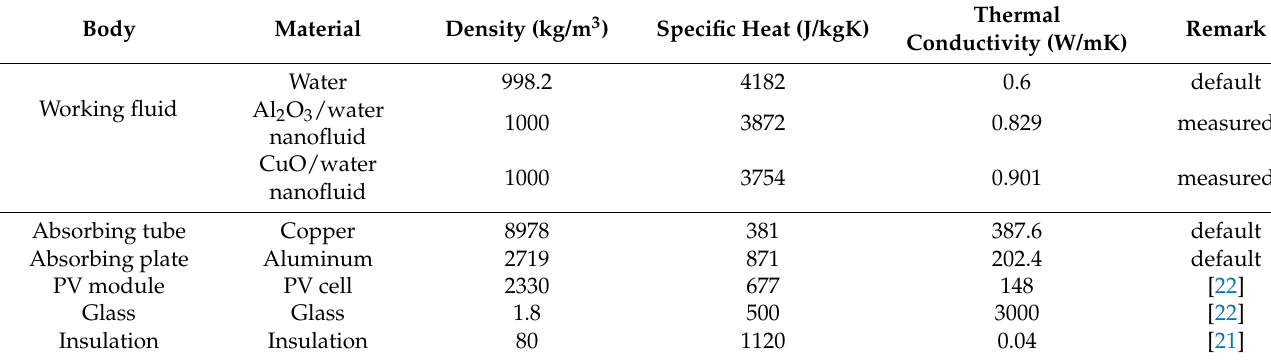
Table 3. Cell zone conditions.